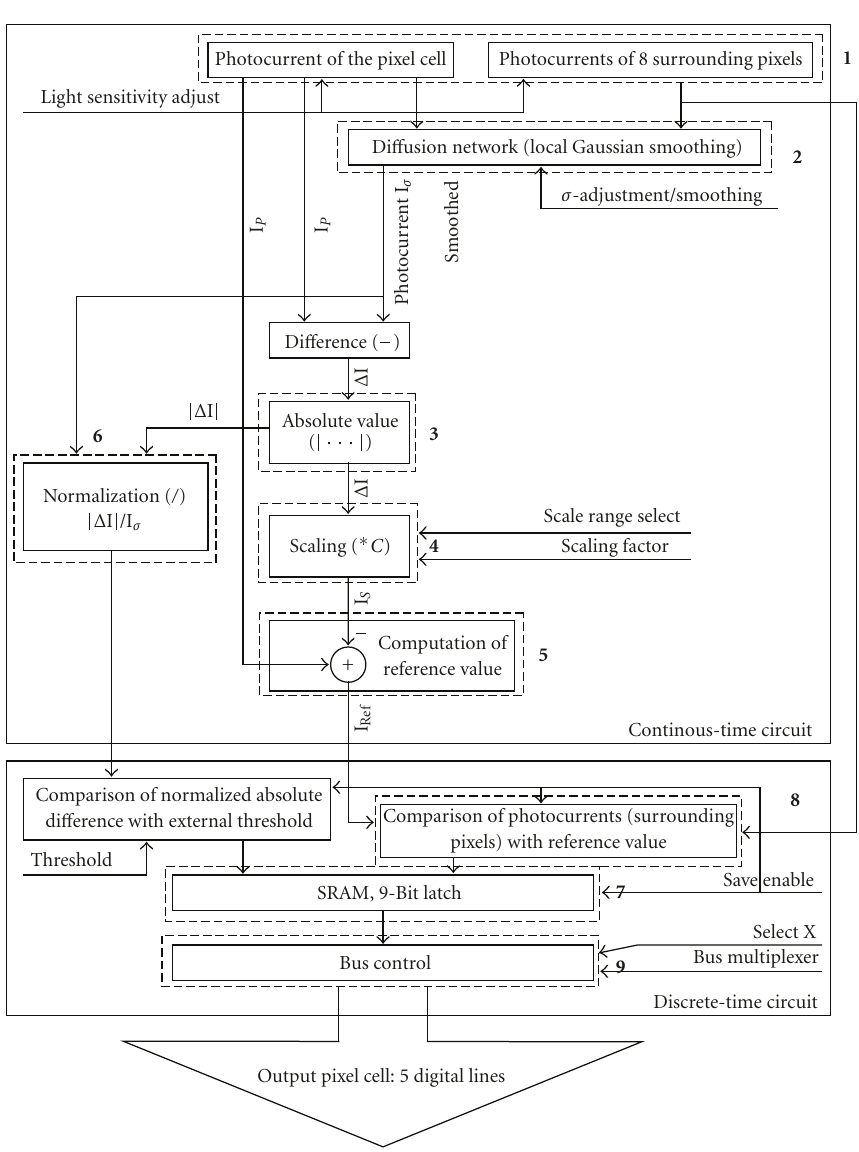
Figure 10: Block diagram of the pixel cell